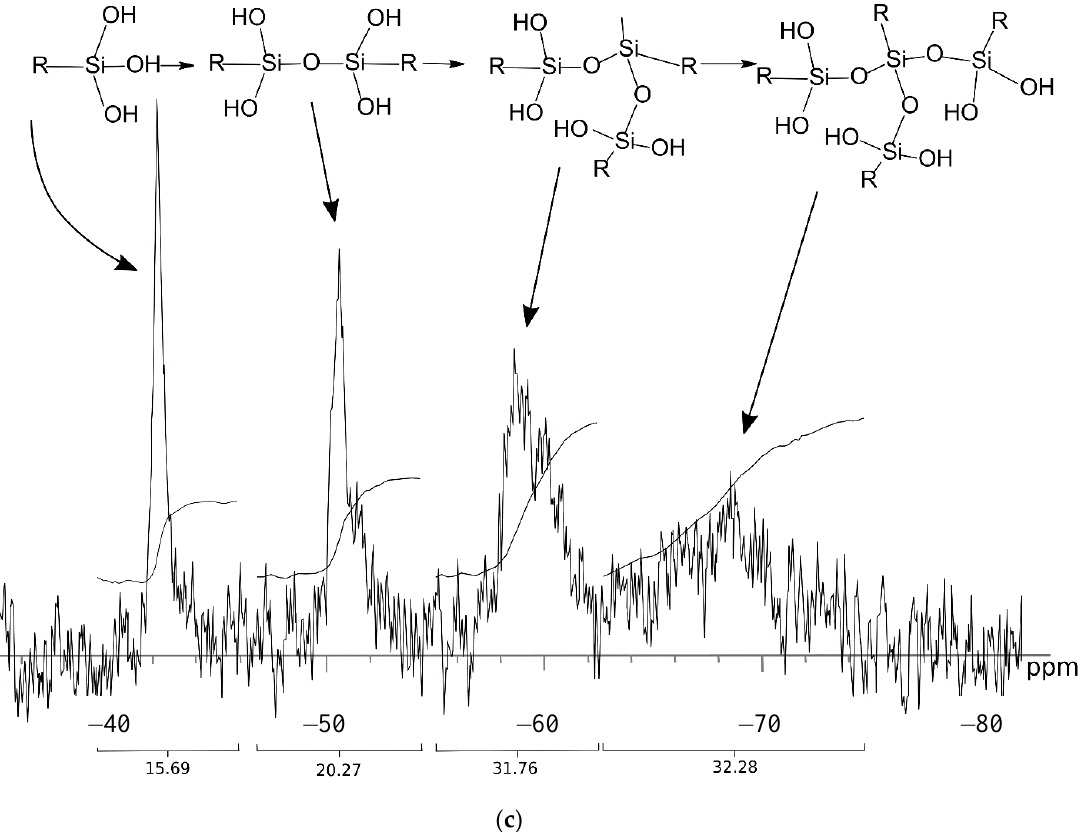
Figure 2. Spectral characterization of the modified HS: ( a ) FTIR spectra of leonardite humic substances (LHS)-APTES100, LHS, and APTES; ( b ) 13 C NMR spectrum of LHS-APTES100; ( c ) 29 Si NMR spectrum of LHS-APTES100.